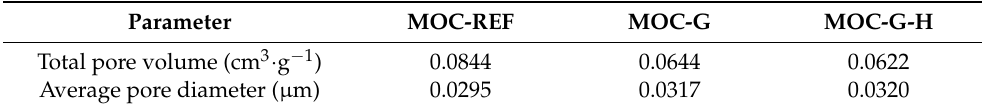
Table 4. Microstructural parameters of the 14-day composites.